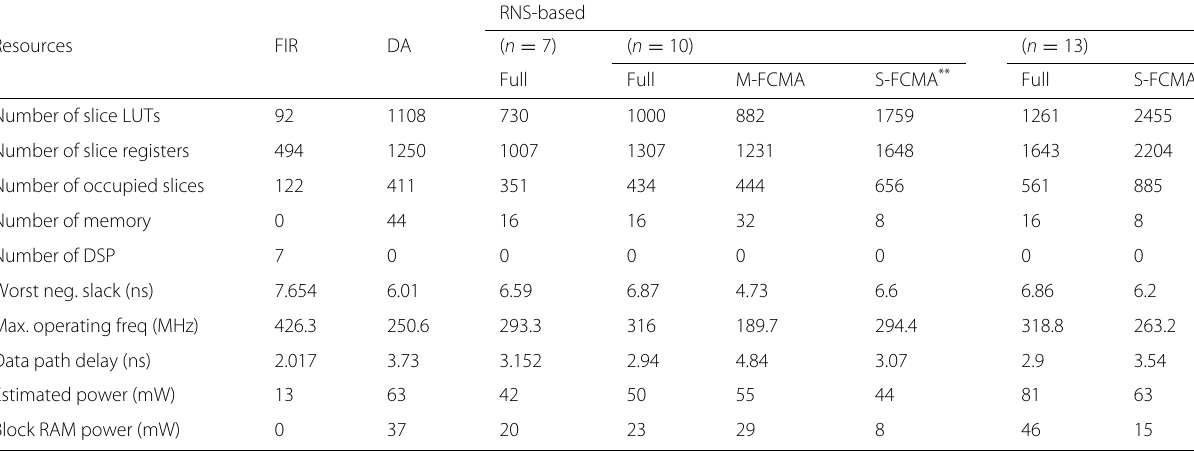
components— i.e., FCMA and reverse-binary